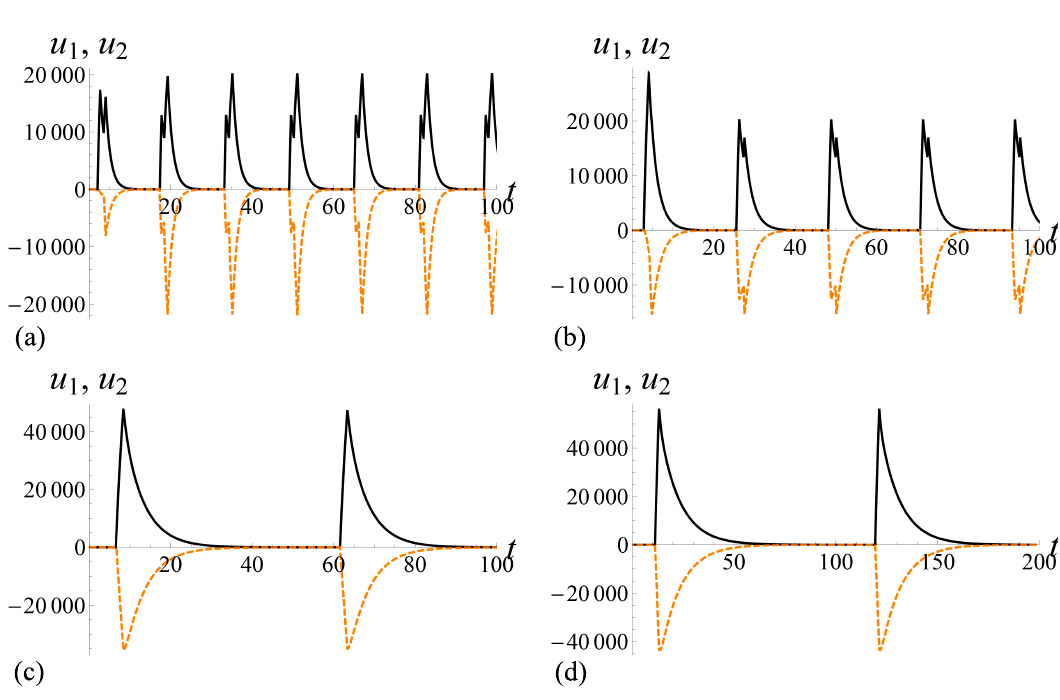
Figure 5. Solutions of system (3) for different values of parameter γ . Values of parameters: T = 2, p = 1.5, λ = 1000, k = 1, x = − 4, ( a ) γ = − 0.1; ( b ) γ = − 0.25; ( c ) γ = − 0.4; ( d ) γ = − 0.45. Black line— u 1 ( t ) , orange dashed line— u 2 ( t )